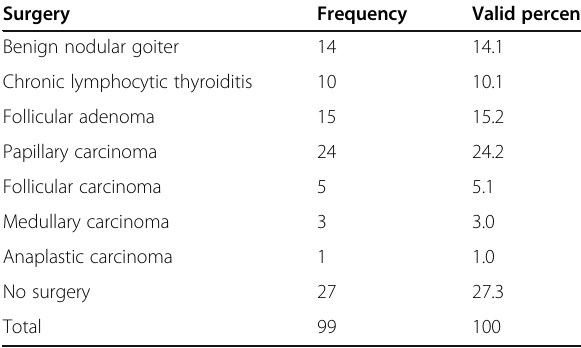
Table 7 Showing the histopathological types of the nodules